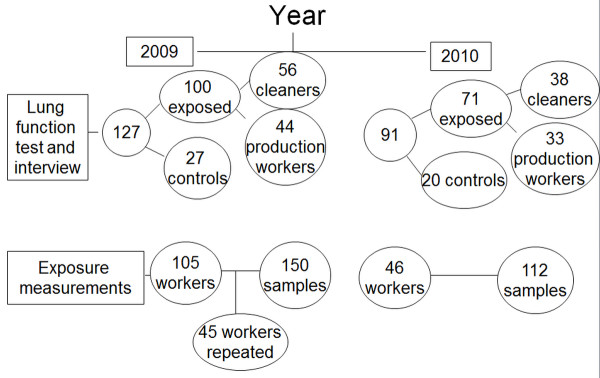
Number of workers sampled for exposure measurements, lung function and interview in 2009 and 2010.